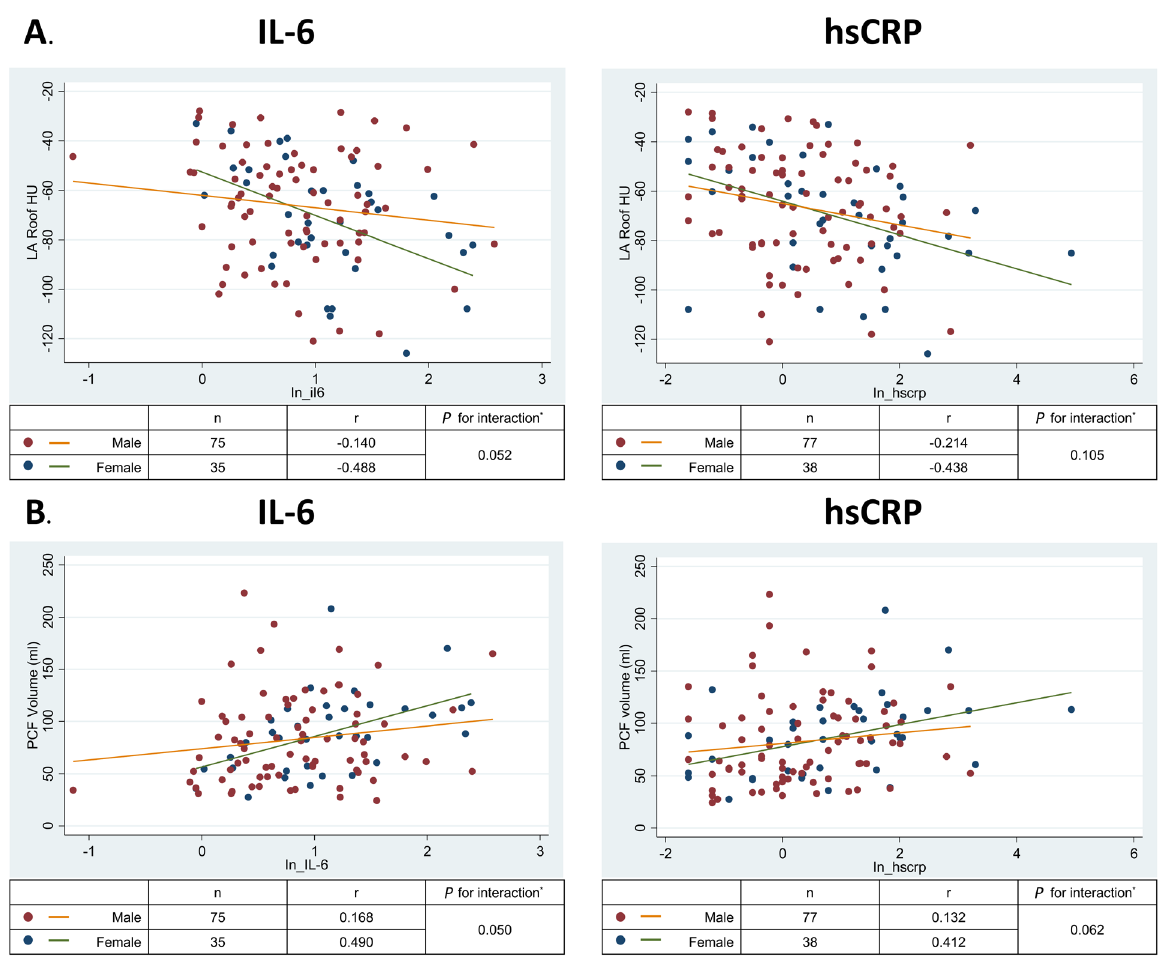
Figure 2. Relationship of left atrial roof pericardial fat density with interleukin-6 by sex.